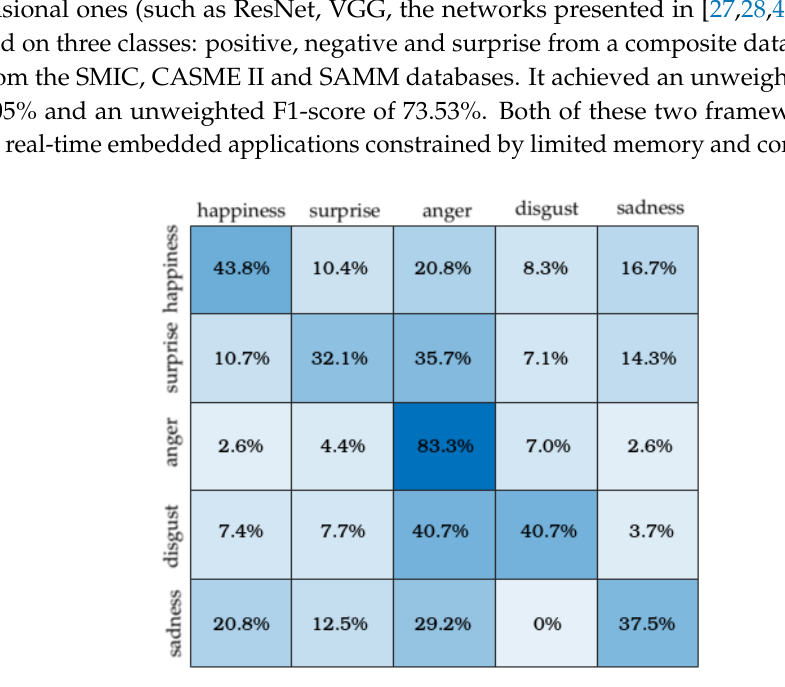
Figure 7. Confusion matrix corresponding to our network with 3 CLs and Vy as input.